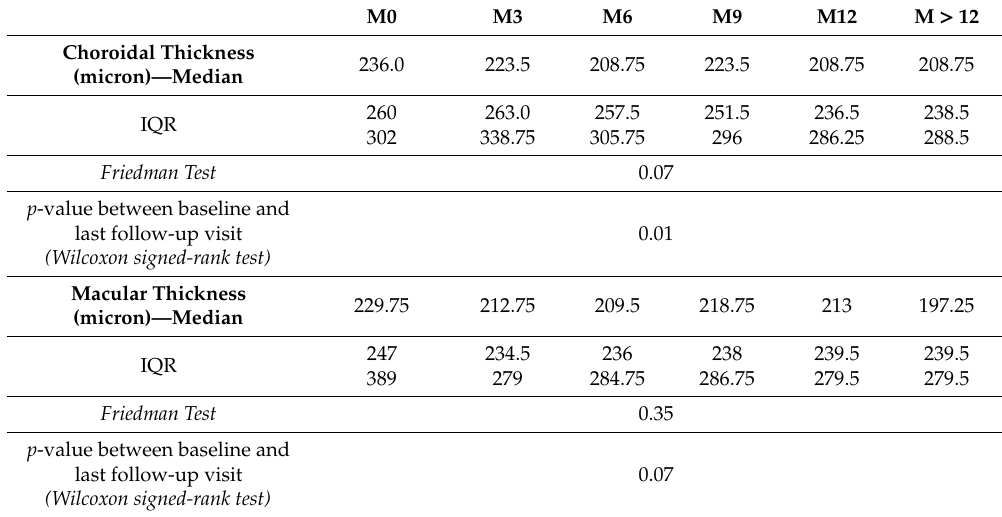
Table 3. Macular thickness, choroidal thickness, and vasculitis at each